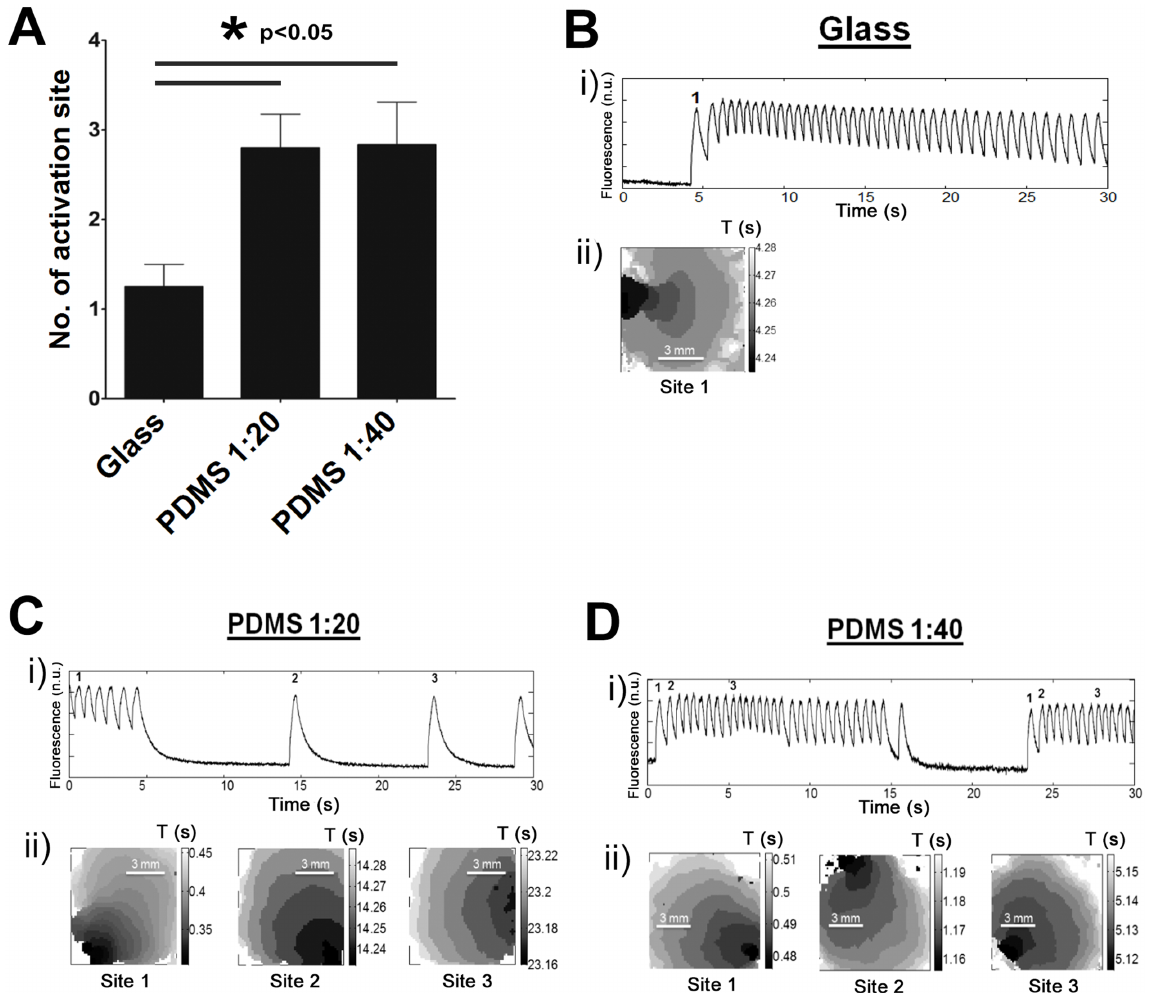
Fig 3. Increased number of initiation sites on PDMS substrate. A. The mean number of activation sites for cardiomyocyte monolayers cultivated on glass, PDMS 1:20, and PDMS 1:40 were 1.3 ± 0.3, 2.8 ± 0.4, and 2.8 ± 0.5 sites, respectively. The mean number of activation sites is significantly higher on PDMS compared to glass (p < 0.05). Examples of activation patterns on different substrates. i) A trace of calcium transients of the spontaneous activity is shown with ii) activation maps of the first beat for each different activation site for glass (B), PDMS 1:20 (C), and PDMS 1:40 substrates (D). Sites are labeled with a number on top of the calcium transient. The corresponding site number is indicated at the time it starts to drive the monolayer (calcium transients without corresponding numbers originated from the same initiation site as the previous one). In these examples, 1 initiation site was observed on glass compared to 3 sites for both PDMS